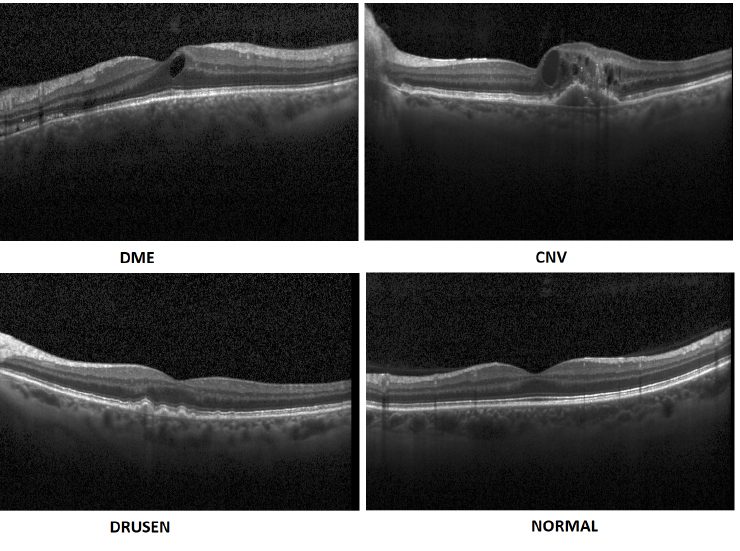
Figure 1. Exemplary OCT B-Scans with diseases and normal image